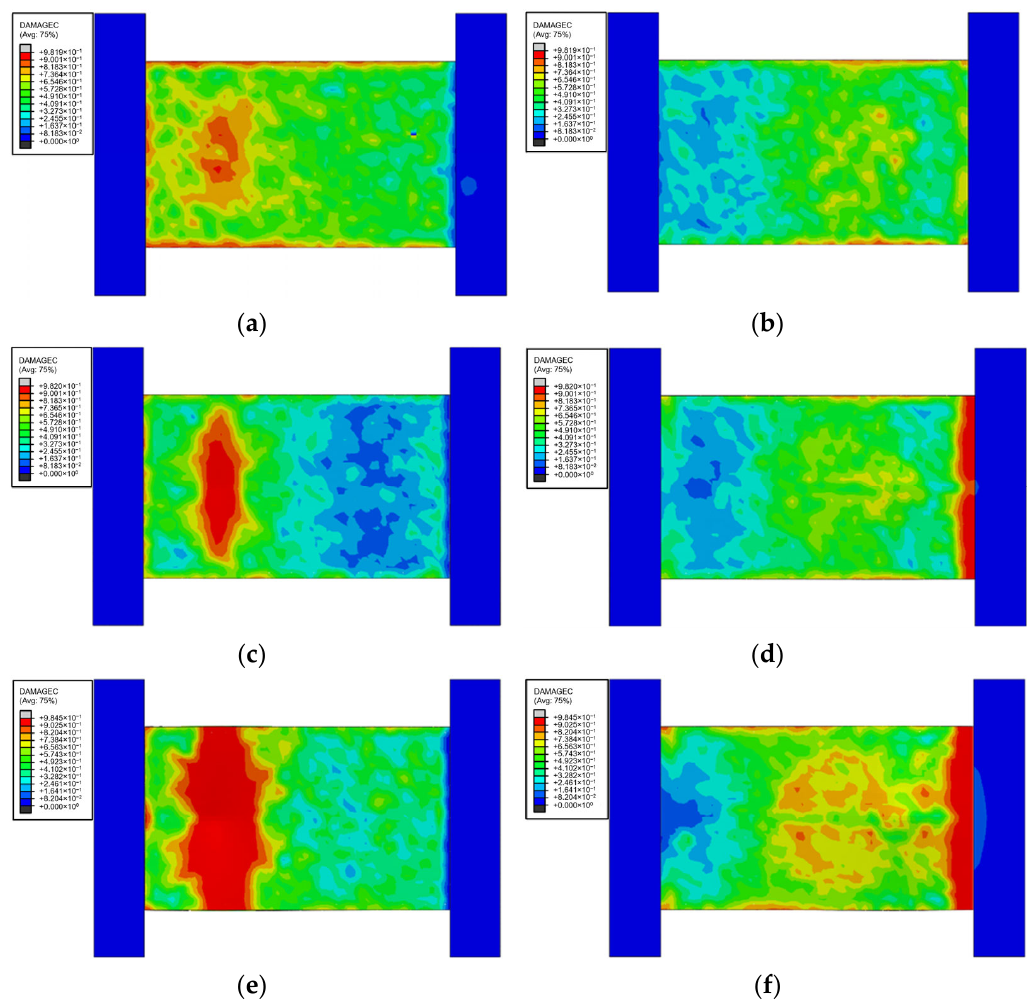
Figure 17. Failure characteristics of the prefabricated shear walls without defects under different explosive equivalent values. ( a ) 3 kg, front blasting surface. ( b ) 3 kg, back blasting surface. ( c ) 5 kg, front blasting surface. ( d ) 5 kg, back blasting surface. ( e ) 9 kg, front blasting surface. ( f ) 9 kg, back blasting surface.